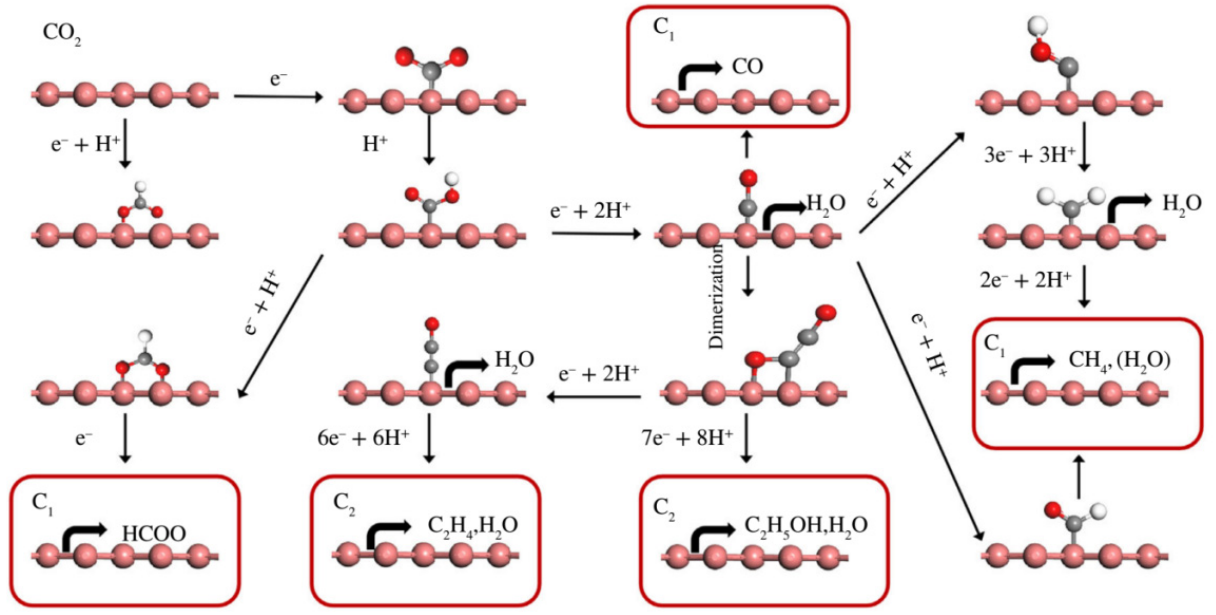
Figure 1. Potential electrochemical CO 2 reduction pathways to form the C 1 products CO, HCOOH and CH 4 and the C 2 products C 2 H 4 and C 2 H 5 OH. Reprinted from [53], Copyright (2019), with permission from Wiley.